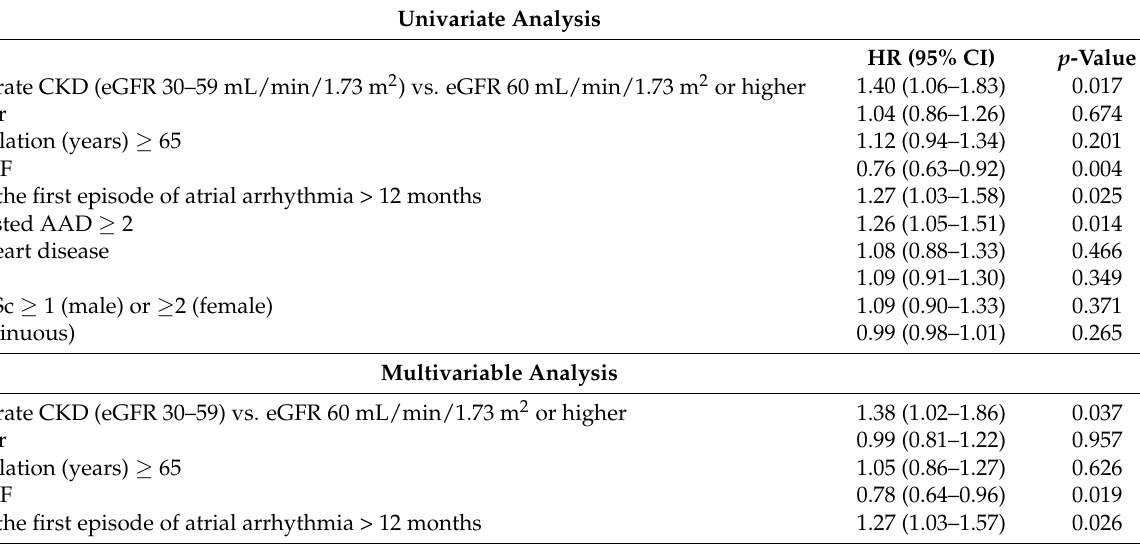
Table 3. Predictors of AF recurrences after the blanking